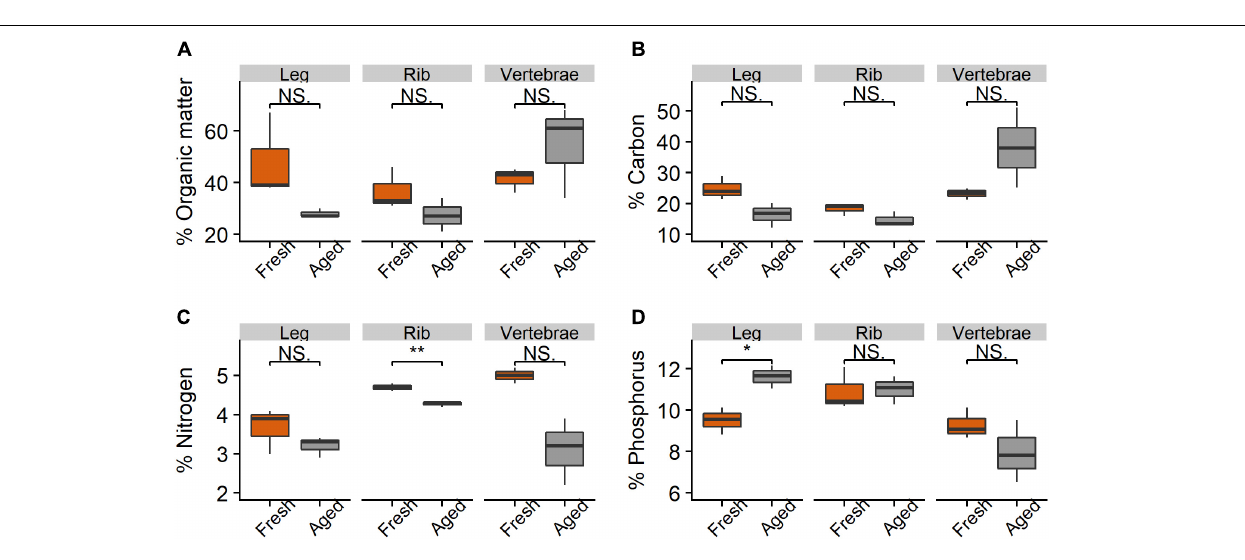
FIGURE 4 | Percent (A) organic matter, (B) carbon, (C) nitrogen, and (D) phosphorus in leg, rib, and vertebrae bones ( n = 3 per bone type) from wildebeest when fresh and after 216 days in the Mara River. Fresh joint bone was compared to aged leg bone. Asterisks indicate significant difference, where * p < 0.05 and ** p <